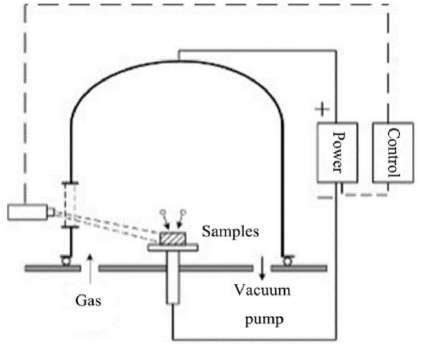
Figure 1. Schematic diagram of low-temperature plasma nitriding device.